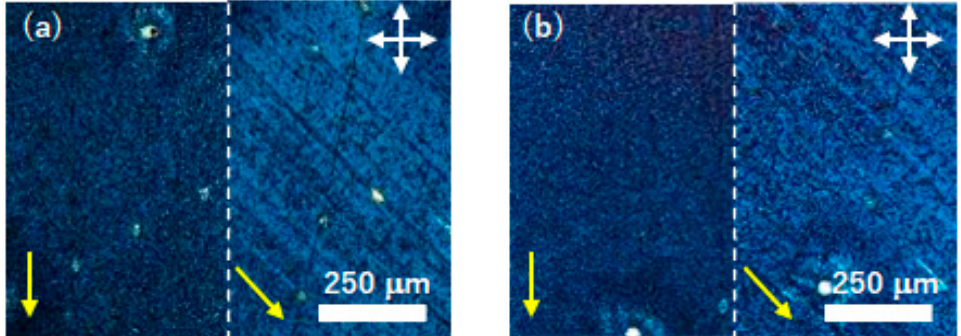
Figure 6. Polarizing optical micrographs of a thin film of compound ( S ) − 1 deposited on FT-treated substrates ( a ) before and ( b ) after the ring-opening polymerization. The polymerization was carried out at 70 °C and the photographs were taken at 30 °C. White arrows indicate the optical axes of the polarizer and analyzer. Yellow arrows denote the direction of the friction in the FT treatment.